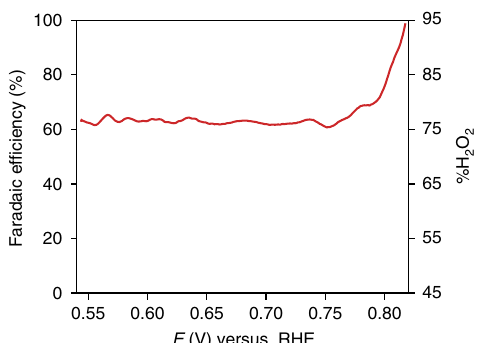
Figure 4 | Faradaic efficiency for H 2 O 2 and %H 2 O 2 . Potential-dependent Faradaic efficiency for H 2 O 2 production and %H 2 O 2 production during ORR catalysed by Ni 3 (HITP) 2 at pH